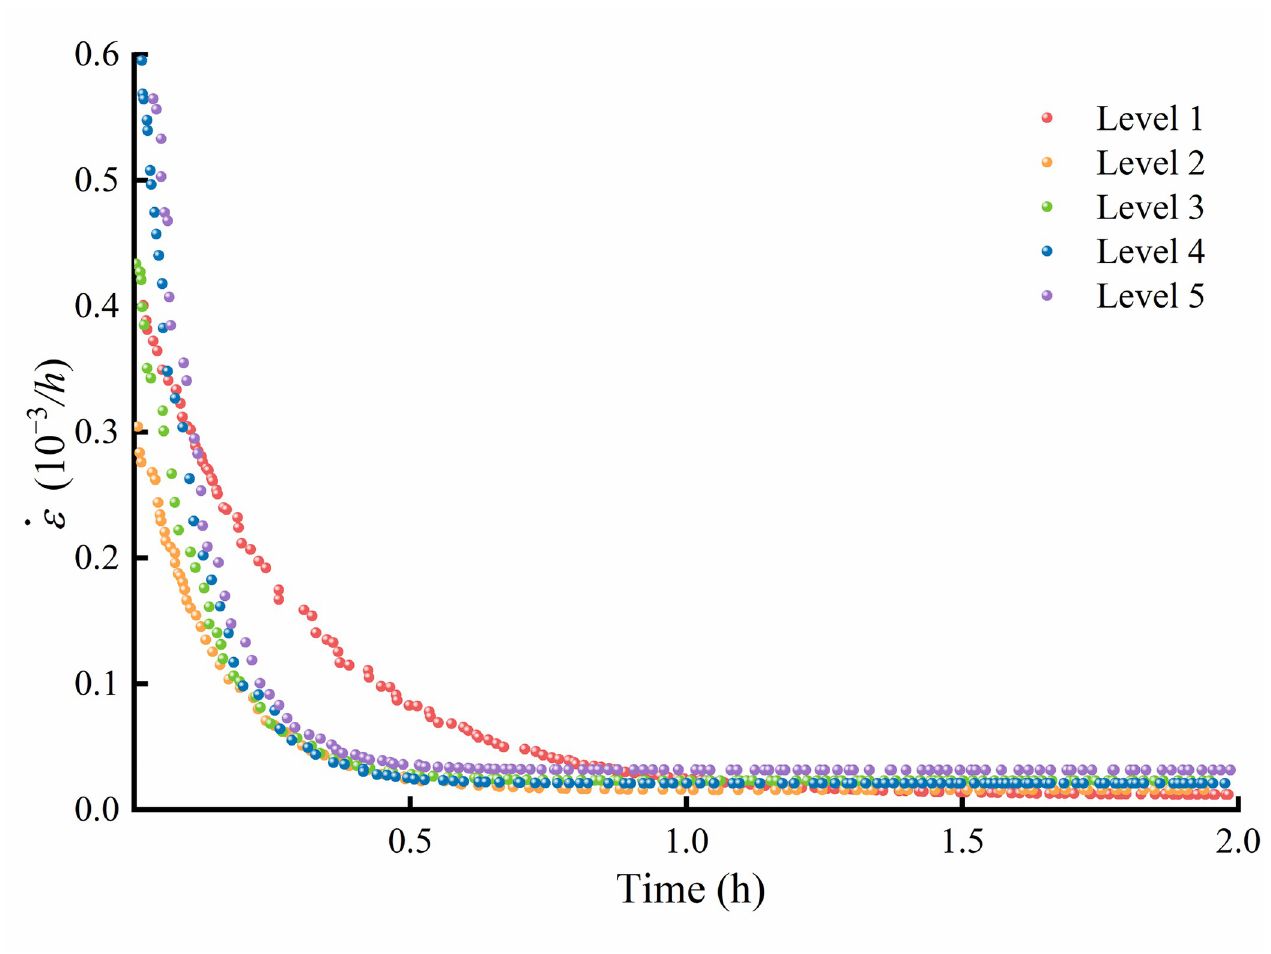
Fig 15. Axial creep crack strain rate of micritic bioclastic limestone from triaxial compression creep tests with 1 MPa confining pressure.